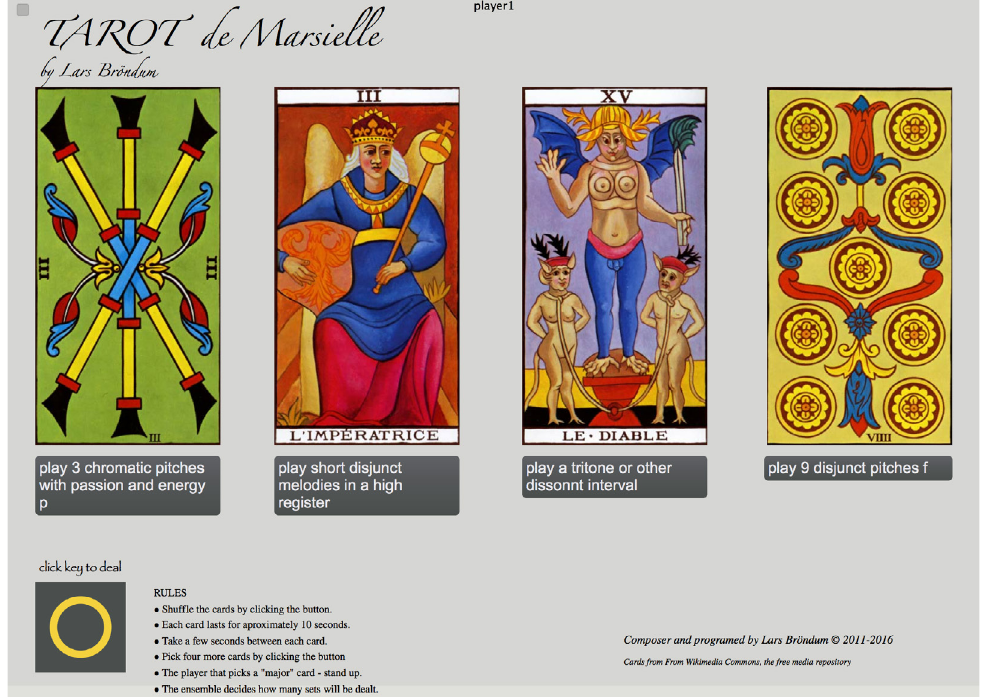
Figure 3. Tarot de Marseille—A Digital Music Card